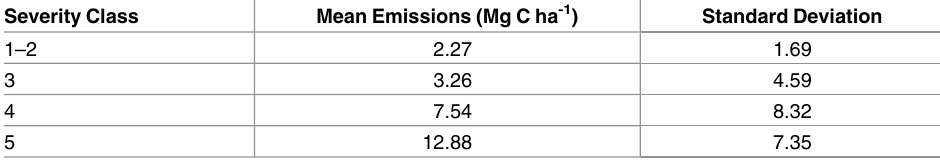
Table 1. Wildfire emissions by severity class. Severity classes 1 and 2 represent surface fire and have the same parameterization. Severity class 3 includessome torching of mature trees. Severity class 4 includes some high severity patches. Severity class 5 is